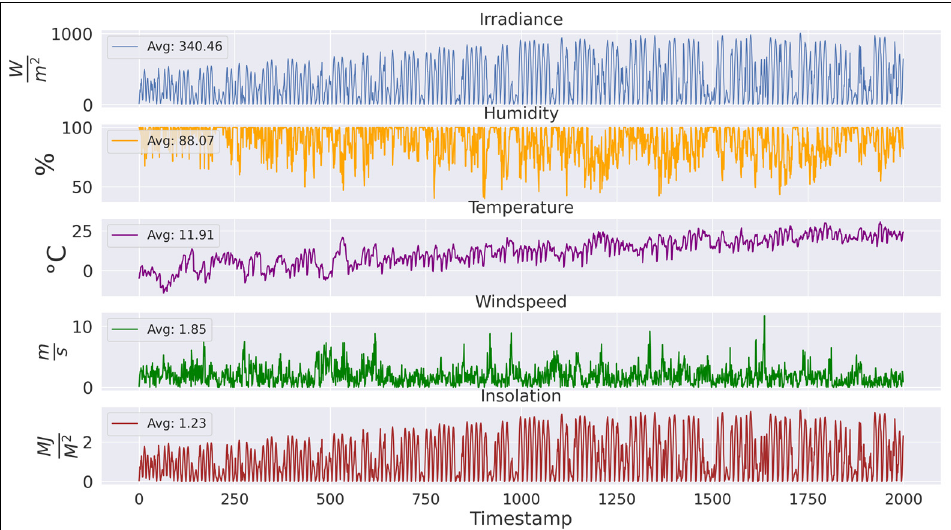
Figure 3. The features of the dataset: Irradiance, Humidity, Temperature, Insolation, and Windspeed, with their average values.